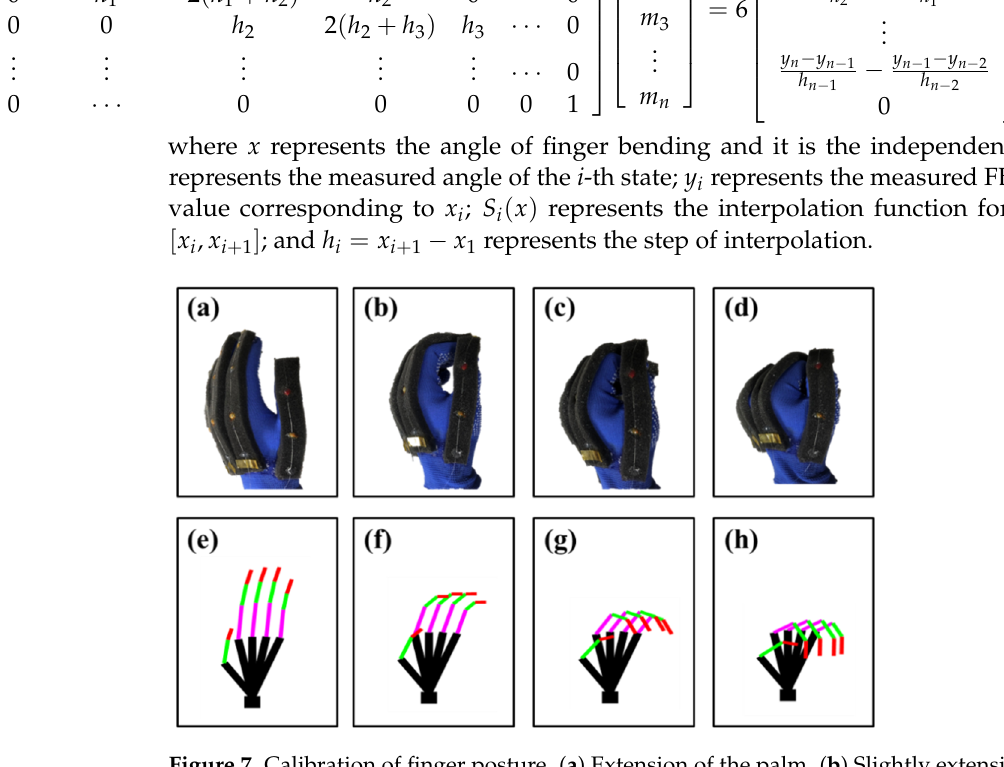
Figure 8. Results of interpolating the reflection peaks of the FBGs using cubic spline interpolation. ( a ) Interpolating of the thumb; ( b ) Interpolating of the index finger; ( c ) Interpolating of the middle finger; ( d ) Interpolating of the fourth finger; and ( e ) Interpolating of the little finger.